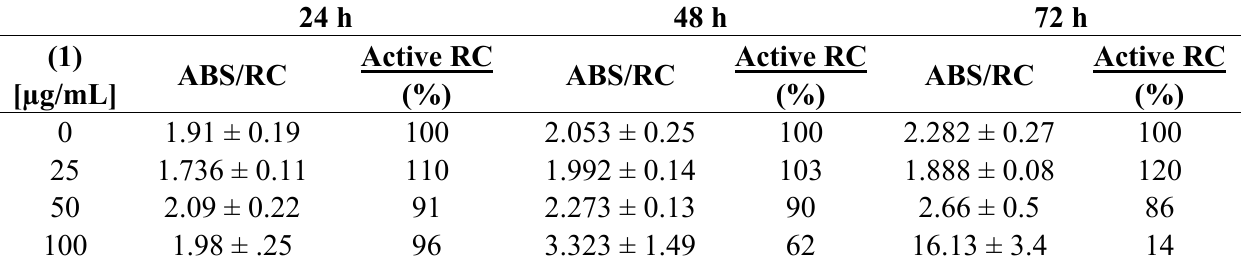
Table 3. Active Reaction Centers calculated as [(ABS/RC) and treated P. ixocarpa plants with β -caryophyllene 50 and 100